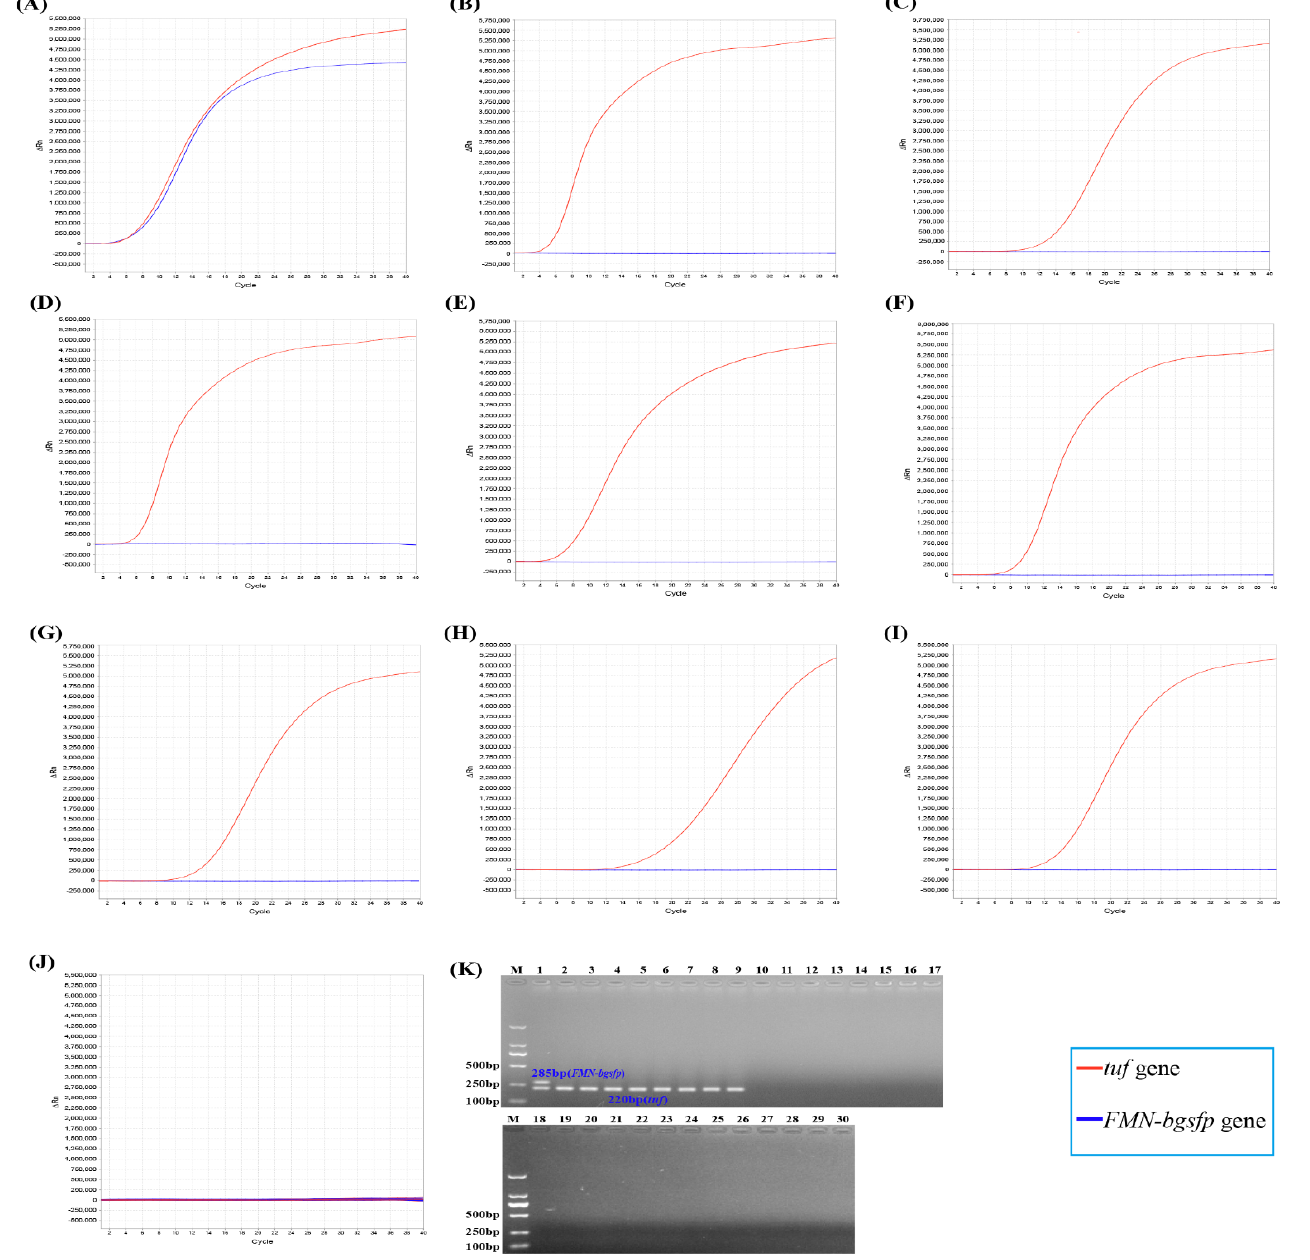
Figure 3. The amplification curves and the results of agarose gel electrophoresis of duplex MIRA- qPCR and duplex conventional PCR. ( A ) S. aureus ATCC 12600 T ; ( B ) S. epidermidis ATCC 14990 T ; ( C ) S. haemolyticus ATCC 29970 T ; ( D ) S. saprophyticus ATCC 15305 T ; ( E ) S. xylosus CHPC 1.3379; ( F ) S. caprae CHPC 1.7854; ( G ) S. pasteuri CHPC 1.7875; ( H ) S. pseudintermedius CHPC 1.7919; ( I ) S. hominis CHPC 1.7929 and ( J ) Vibrio parahaemolyticus CHPC 1.1001, Klebsiella pneumonia CHPC 1.1005, Vibrio